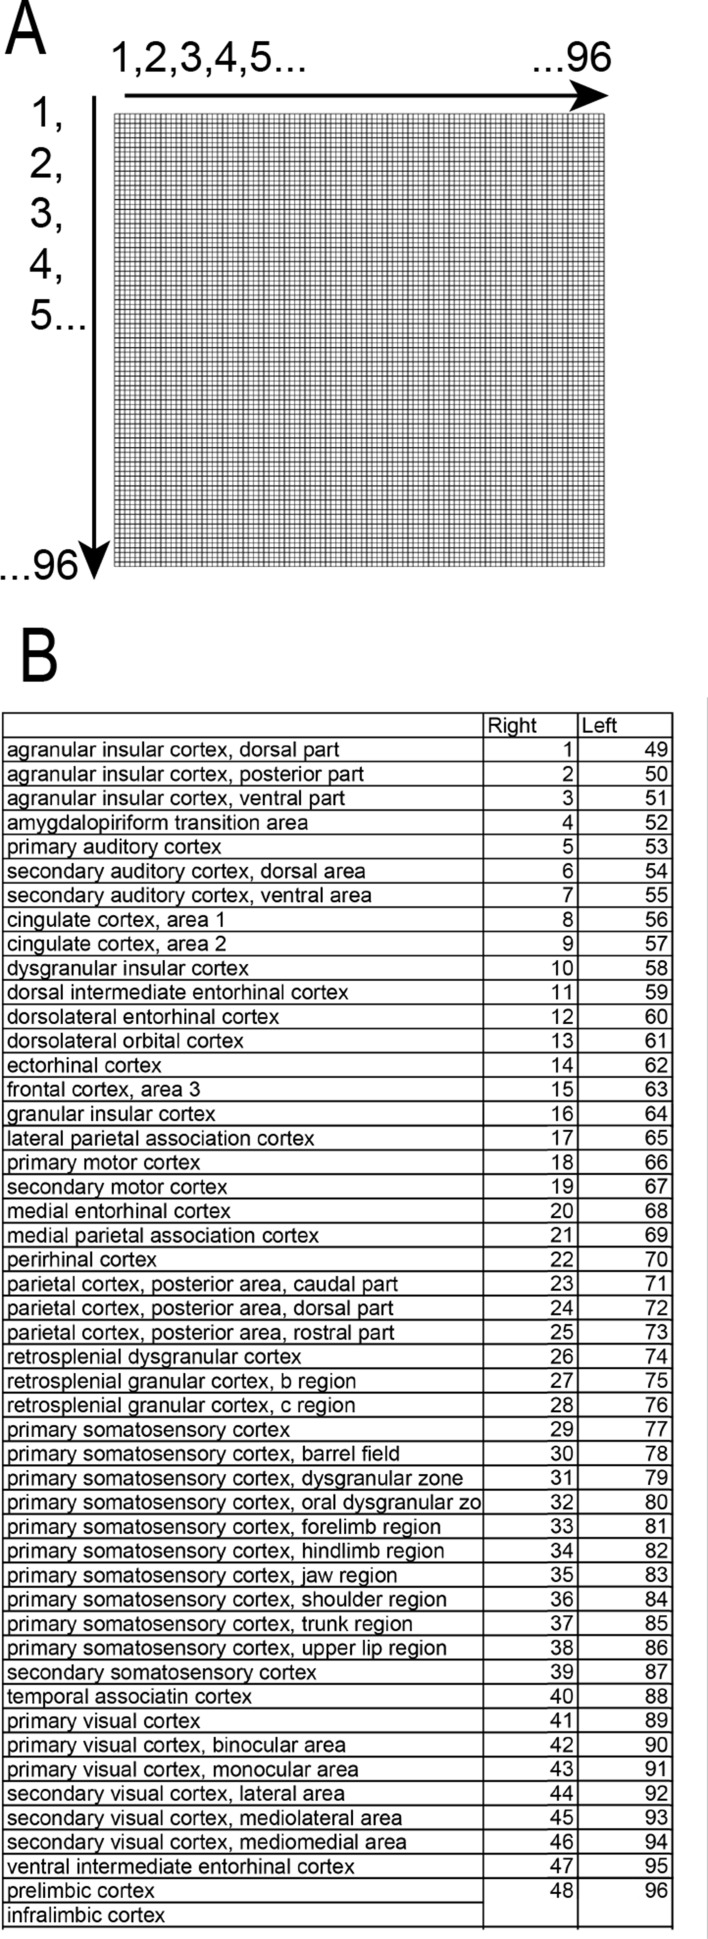
Cortical areas used for connectivity analysis.(A) Configuration of the distribution of cortical areas within the connectivity maps. (B) Corresponding localization of each area used in the connectivity analyses. The area’s names and distribution are taken from the Valdes-Hernandez et al atlas (Valdés-Hernández et al., 2011).